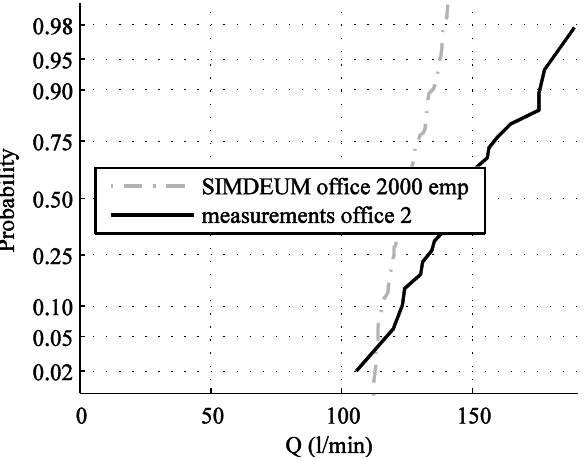
Figure 1. Frequency distribution of measured (24 weekdays at 1s scale) and simulated (100 days at 1s scale) peak demand values for o ffi ce II: Q = MMF cold [Lmin − 1